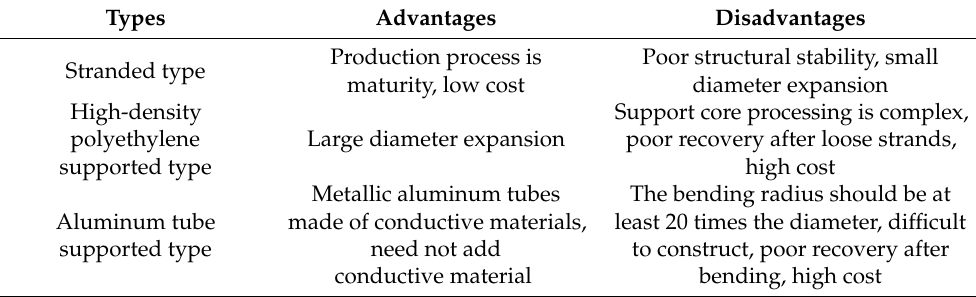
Table 2. Comparison of advantages and disadvantages of different types of DECs.